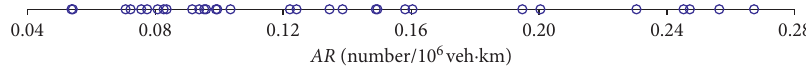
Figure 5: Wide variation in AR s.